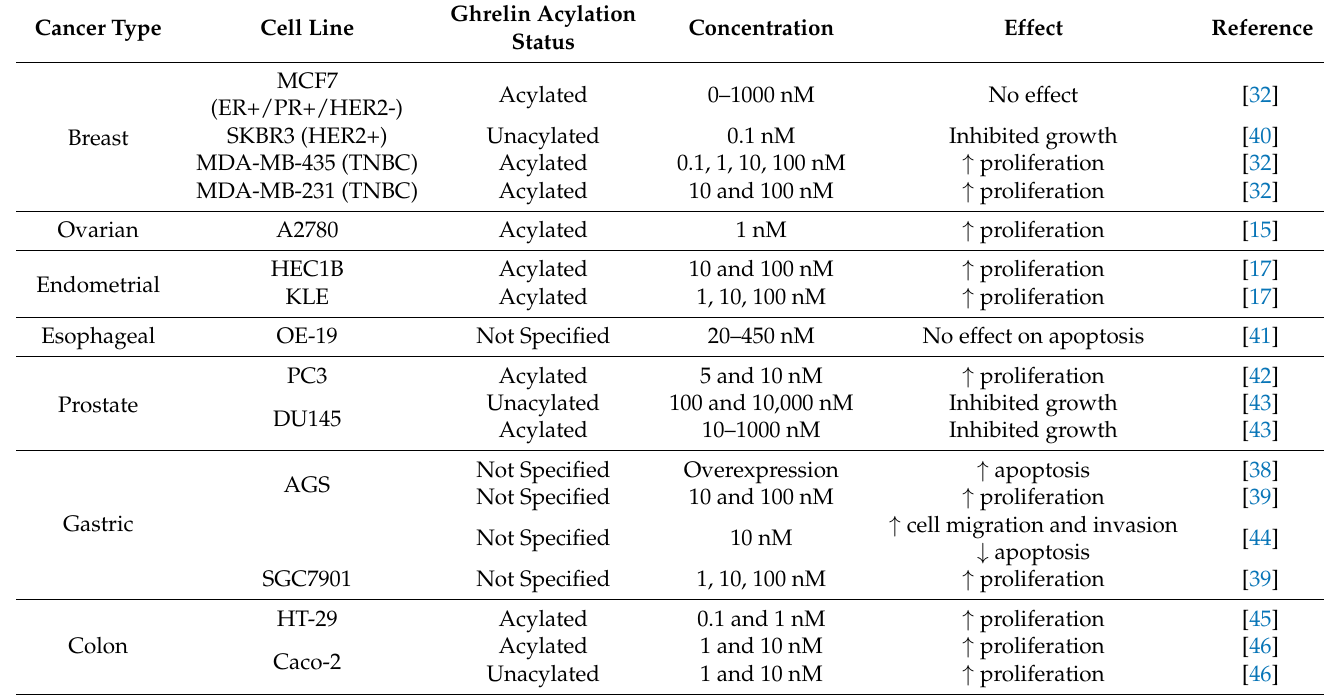
Table 1. Summary of in vitro studies of ghrelin across cancer types, including dose, acylation status of ghrelin, and effects on cell proliferation and survival. Arrows represent directionality: increased/enhanced ( ↑ ) or decreased/suppressed ( ↓